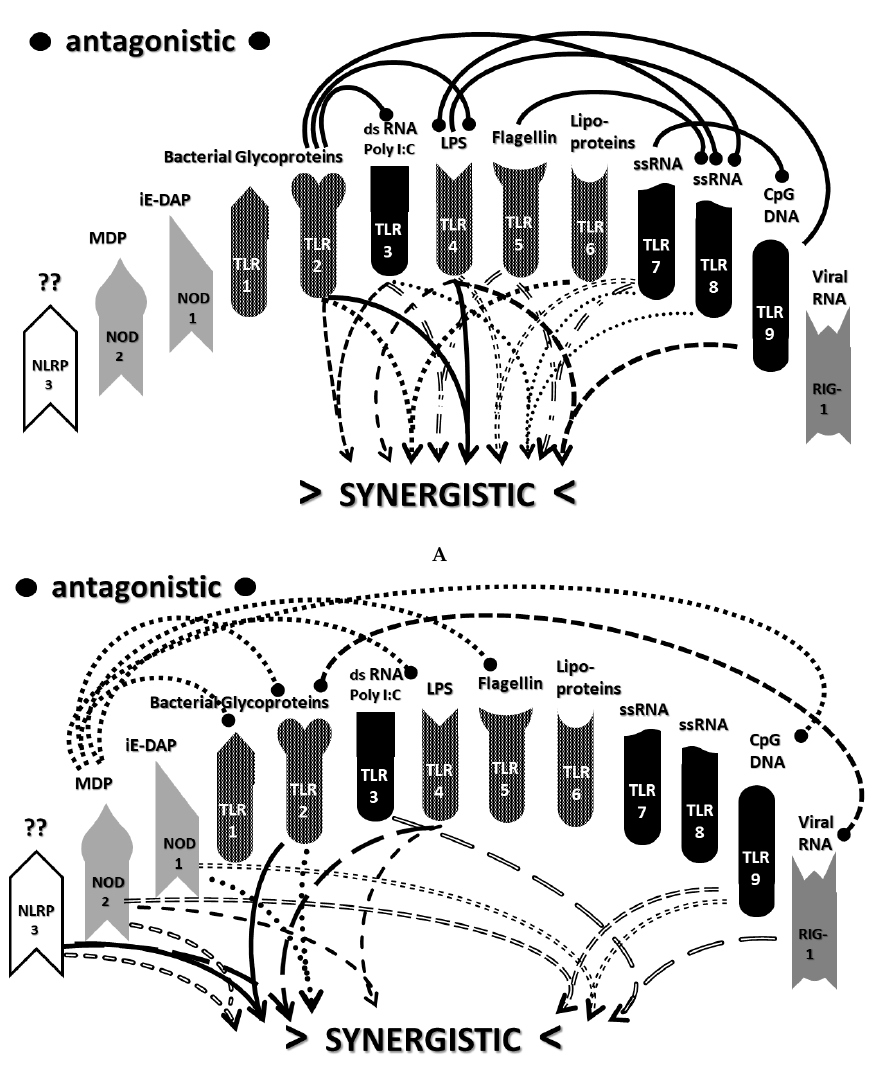
Figure 2. ( A ) Known synergistic and antagonistic interactions among TLR. Antagonistic effects are illustrated so that the receptor that is antagonized has a large dot above it. The result is a very complex system of feedforward and feedback loops, many of which involve bacterial antigens (TLR1,2,4, 5 and 6) with each other and with viral antigens (TLR3, 7, 8 and 9). Receptors activated by viral antigens also tend to synergize with each other. This figure is based on less-complete versions in [51,56] that were augmented with reference to the following studies [57–75]. The different line styles have no intrinsic meaning but are used to help the reader more easily trace the pairs of interactions, in the case of synergisms, and the source and direction of the interactions, in the case of antagonisms. ( B ) Known synergistic and antagonistic interactions between NLR, NLRP3 and RIG1 and with TLR. Antagonistic effects are illustrated so that the receptor that is antagonized has a large dot above it. The result is a very complex system of feedforward and feedback loops, many of which involve bacterial antigens with each other (TLR2 and 4 and NOD 1 and 2), bacterial antigens with viral antigens (NOD1 and NOD2 with TLR9 and TLR3 with RIG1) and between viral antigens (TLR3 and RIG1). This figure is based on less-complete versions in [51,56] that were augmented with reference to the following studies [57–75]. The different line styles have no intrinsic meaning but are used to help the reader more easily trace the pairs of interactions, in the case of synergisms, and the source and direction of the interactions, in the case of antagonisms.